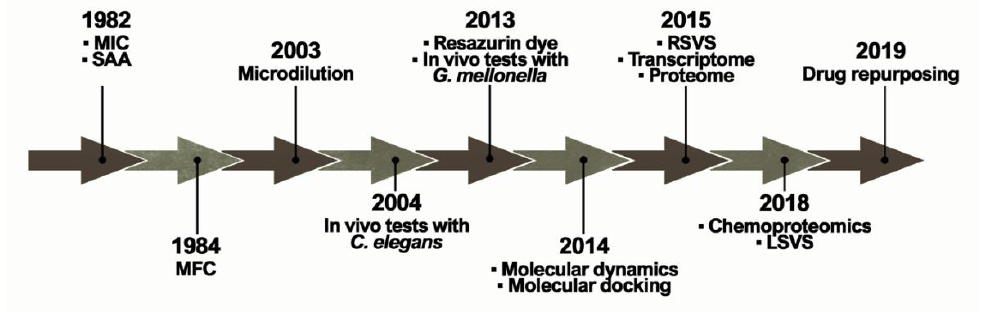
Figure 2. Methodologies used in the search and evaluation of anti-paracoccidioidomycosis compounds. MIC (Minimal Inhibitory Concentration), SAA (Synergistic Activity Assay), MFC (Minimal Fungicidal Activity), RSVS (Receptor shape-based Virtual Screening), LSVS (Ligand shape-based Virtual Screening).